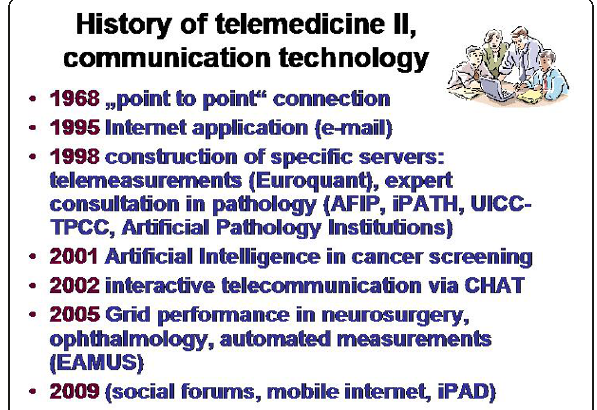
Figure 4 History of telemedicine related to the communication technology .